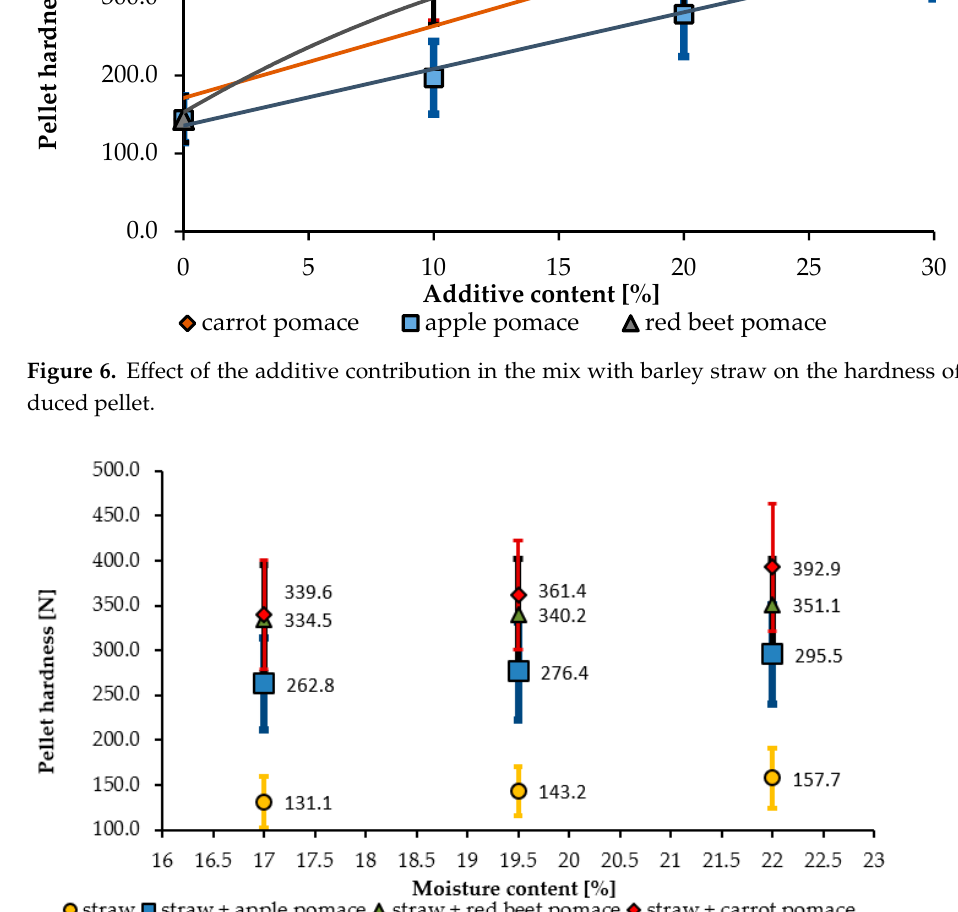
Figure 7. Influence of raw material moisture content on the hardness of produced pellet.